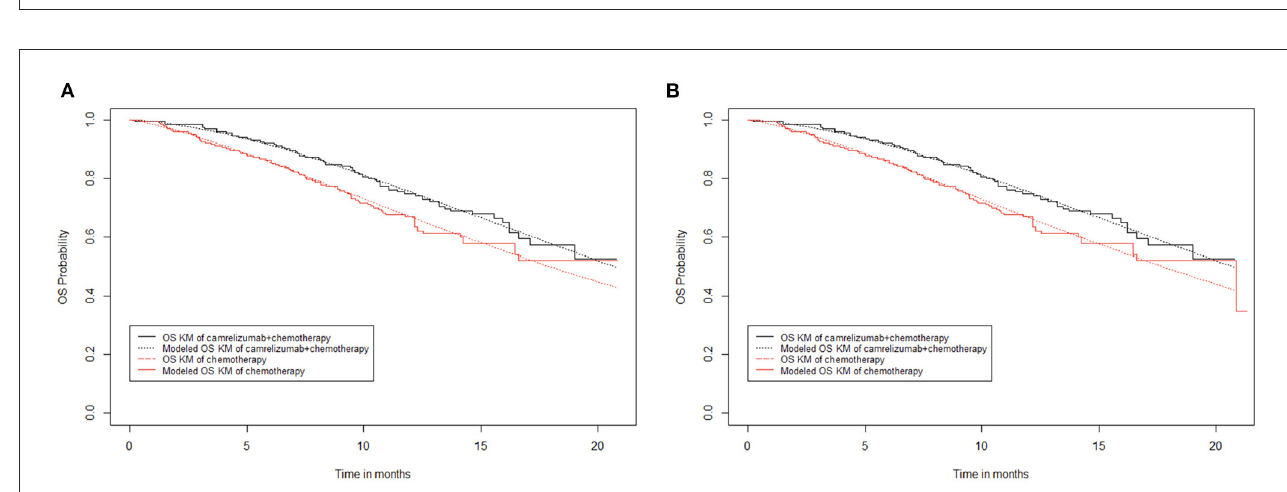
FIGURE3 Kaplan–Meier survival curves for overall survival. (A) Abandon extreme points. (B) Keep extreme